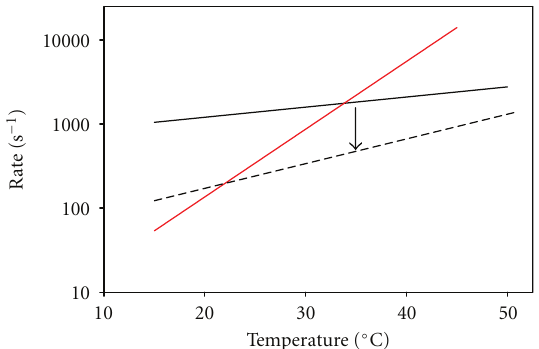
Figure 6: Temperature dependence of two apparent rate constants that may limit actin filament sliding speed at pCa 5. Data in Figure 3 ( T < ∼ 54 ◦ C) for sliding speed of regulated thin filaments were fitted to (2). The inverse of each of the exponential rate terms in the denominator of (2) is plotted: for WT regulated thin filaments, one rate exhibits only slight temperature sensitivity (solid black line) while the other is markedly temperature sensitive (red line). The rate-limiting step for filament sliding is the smaller of the two rates, and T t is the intersection of the two lines. The less temperature sensitive rate is also shown for unregulated F-actin (dashed black line; data from Figure 3). Note that by assuming the temperature-sensitive rate (red line) is similar for both instances, decreasing the less temperature sensitive rate (black arrow, as observed experimentally with unregulated F-actin) decreases T t